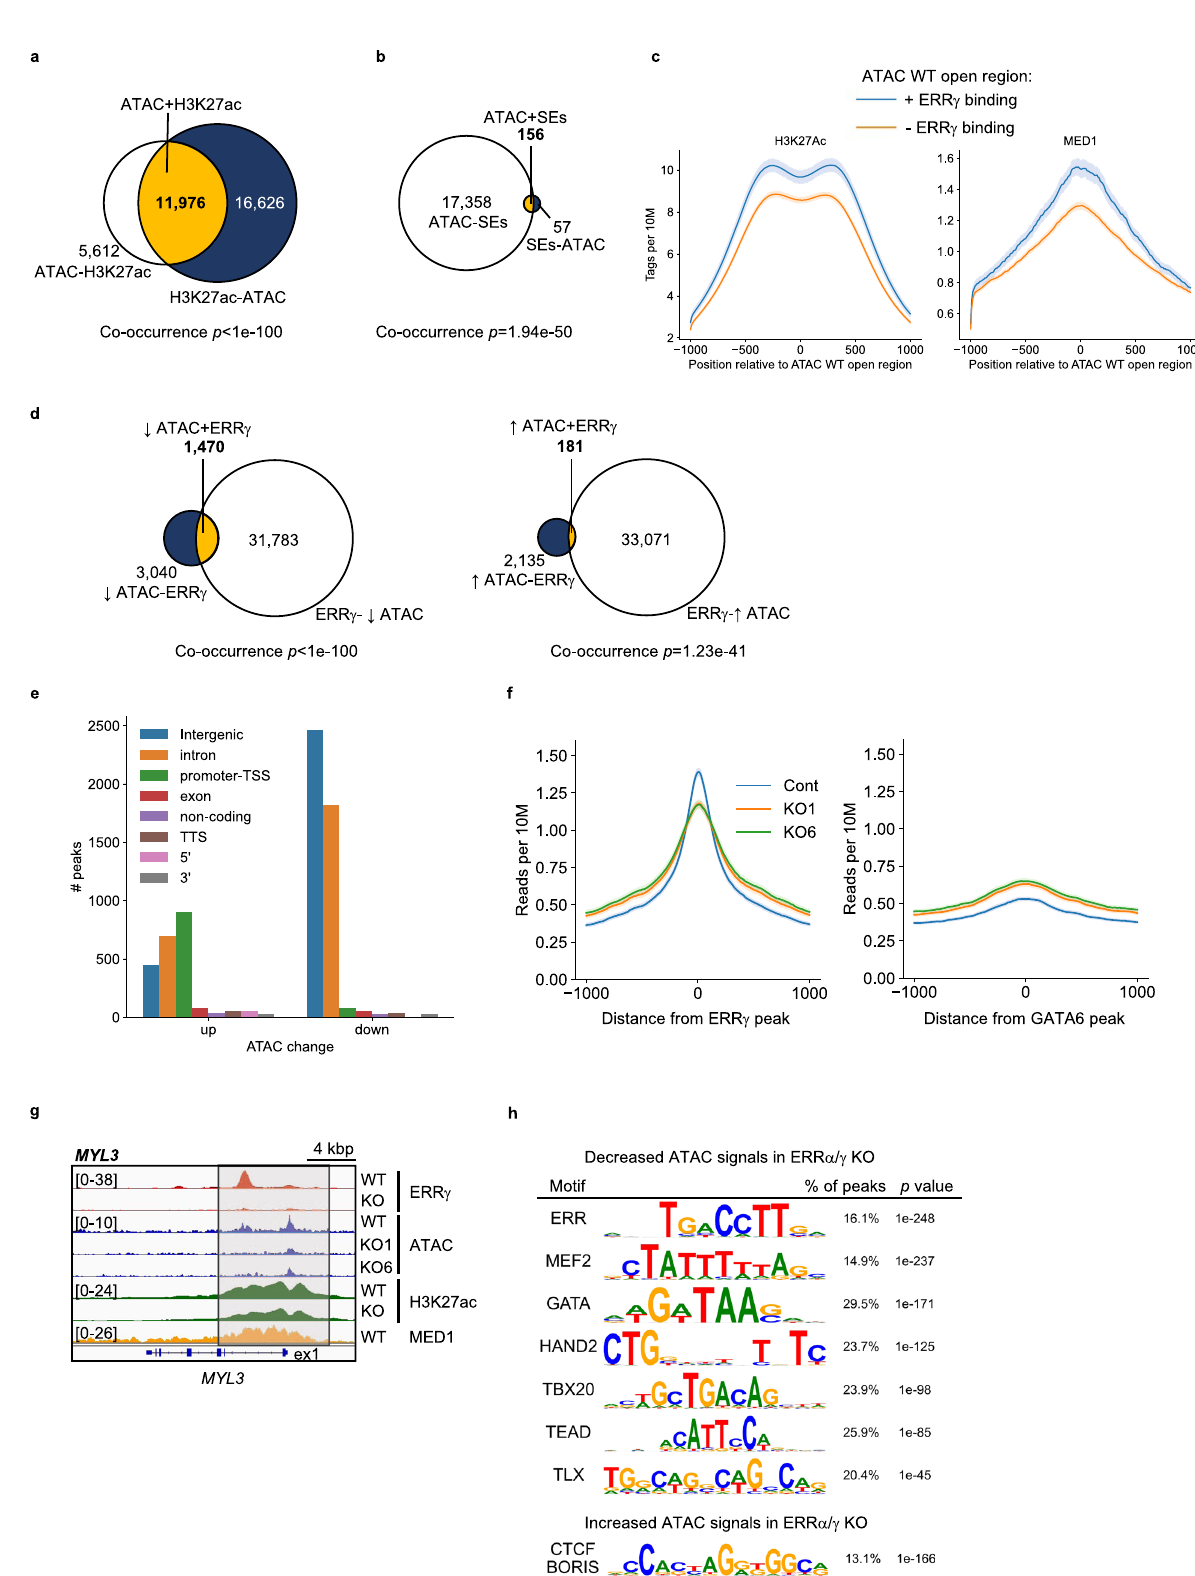
ERR target gene expression. Published GATA4 target